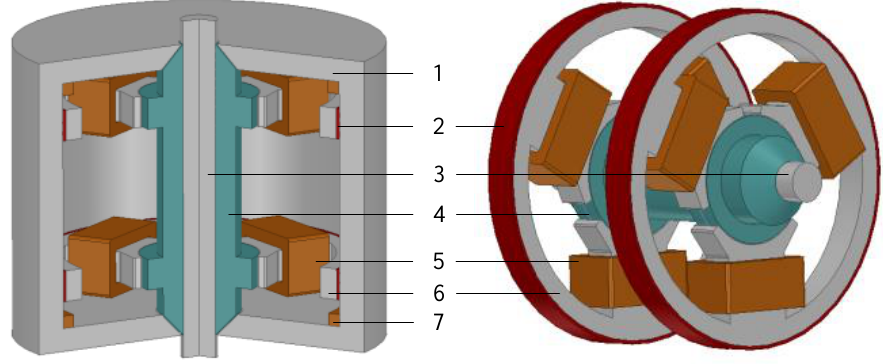
Figure 1. A 3D model of the 5-DOF AC–DC HMB.